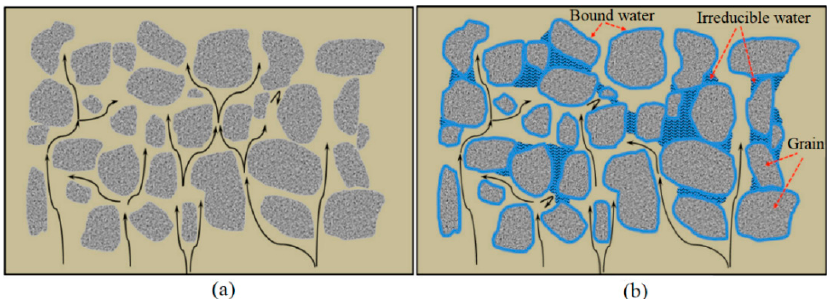
Figure 20. Thickness of the mixed zone for different residual water saturations.